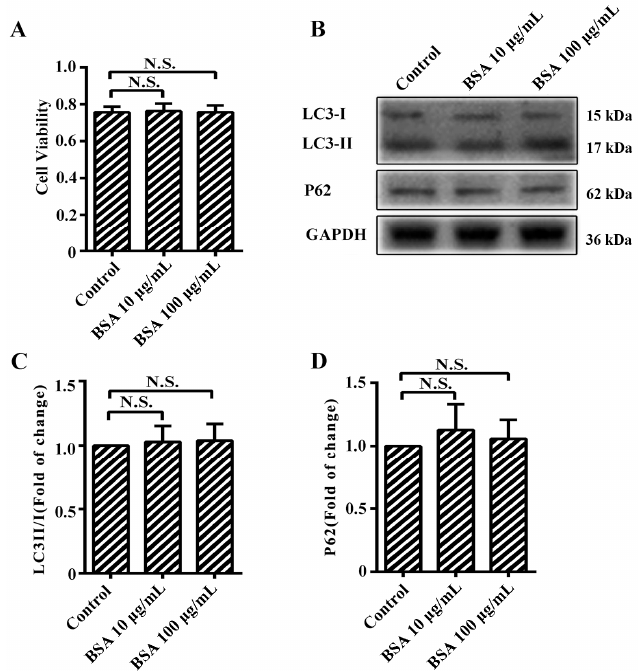
Figure A1. The effect of 100 µg/mL BSA on cell viability and autophagy. ( A ) Cell viability was detected by methyl thiazolyl tetrazolium (MTT) assay; ( B ) The protein expression of microtubule- associated protein 1 light chain 3 (LC3)-II, LC3-I, and p62 were analyzed using western blotting, and glyceraldehyde 3-phosphate dehydrogenase (GAPDH) was used as a control; ( C , D ) The band intensity was quantified using Image J 1.47, normalized by GAPDH. * p < 0.05 compared with control group. N.S., no statistical significance.